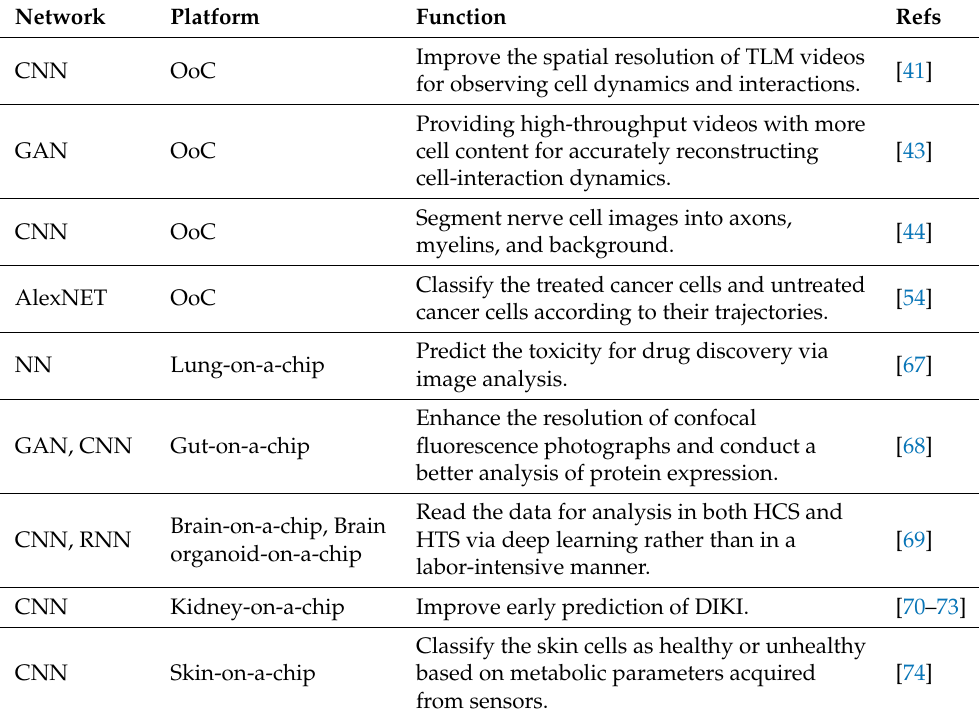
Table 1. Summary of different applications of deep learning used for